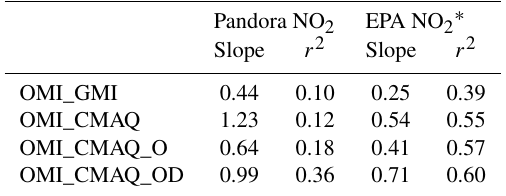
Table 2. Slope and r 2 for all four OMI satellite products com- pared to Pandora NO 2 from July 2011 and EPA ground monitor NO 2 ∗ observations from June and July 2008–2012. Pandora NO 2 is compared to the OMI NO 2 total column products, while the EPA ground monitors are compared to OMI NO 2 tropospheric col- umn products. Figures 7a and 9a show values for OMI_GMI and OMI_CMAQ_OD